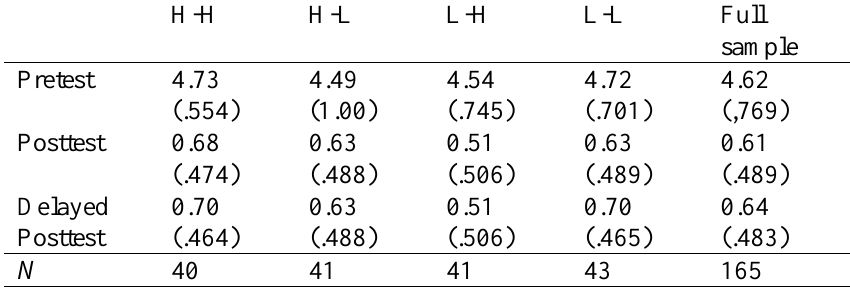
Mean Performance on Content Tasks and Standard Deviation .